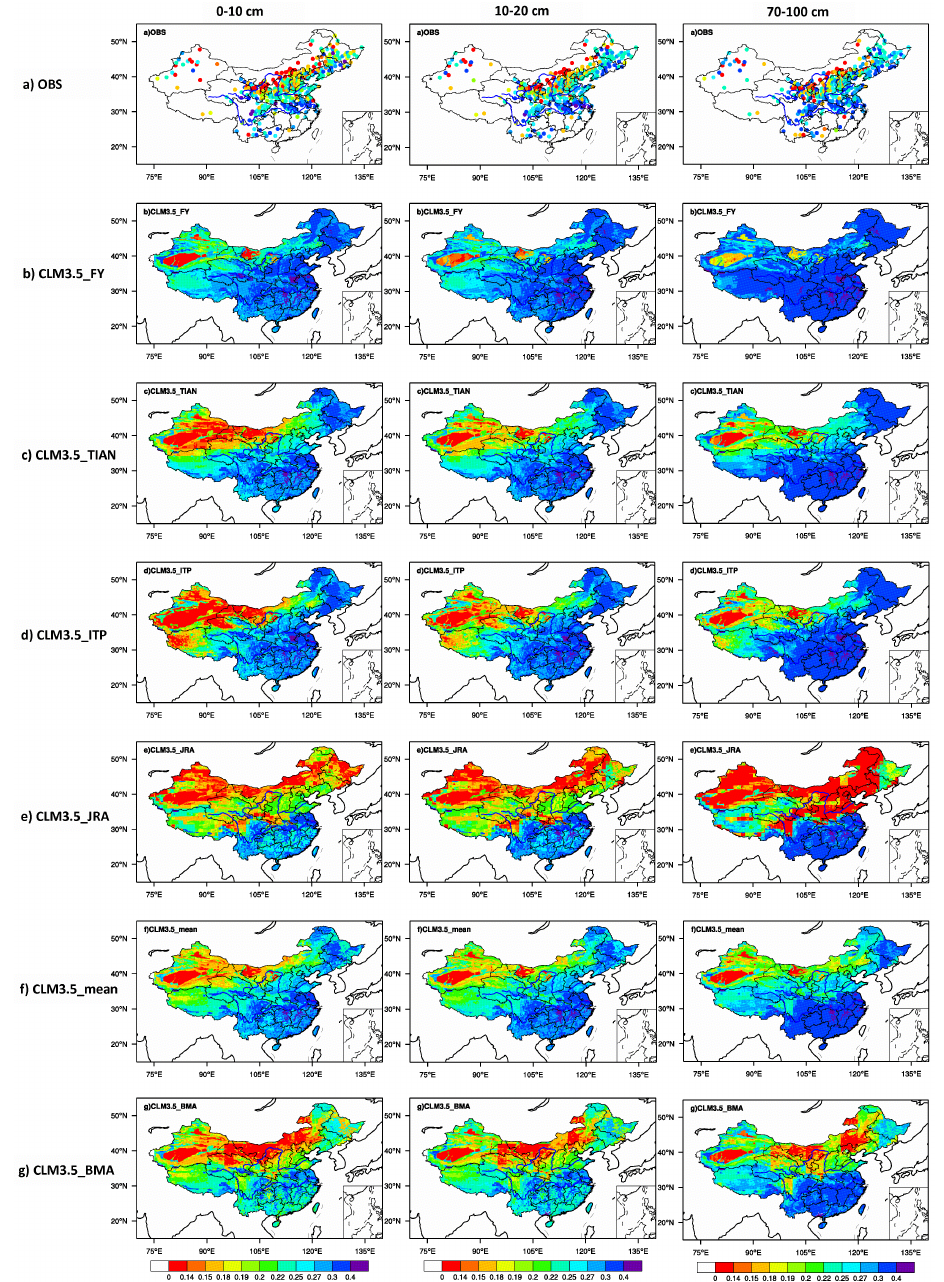
Fig. 5. Mean volumetric soil moisture (m 3 m − 3 ) averaged for July 2005–June 2010 in 0–10cm soil layer (first column), 10–20cm soil layer (second column), 70–100cm soil layer (third column): (a) observations (OBS); (b) CLM3.5 FY; (c) CLM3.5 TIAN; (d) CLM3.5 ITP; (e) CLM3.5 JRA; (f) CLM3.5 mean; (g) CLM3.5